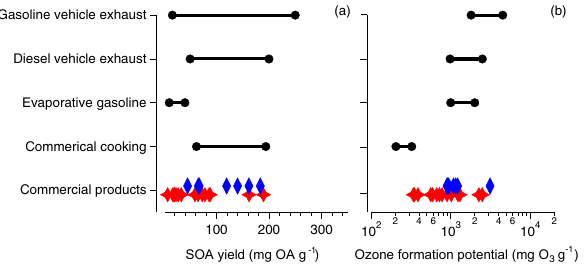
Figure 5. Comparison of (a) SOA yields and (b) ozone forma- tion potential of five major sources. Blue markers represent aver- age yields of the product- and process-related source categories in Fig. 3 and do not include “missing” emissions. The red markers show yields of sampled consumer products calculated from specia- tion obtained after GC-MS analysis. All are shown as a function of mass emitted, not product